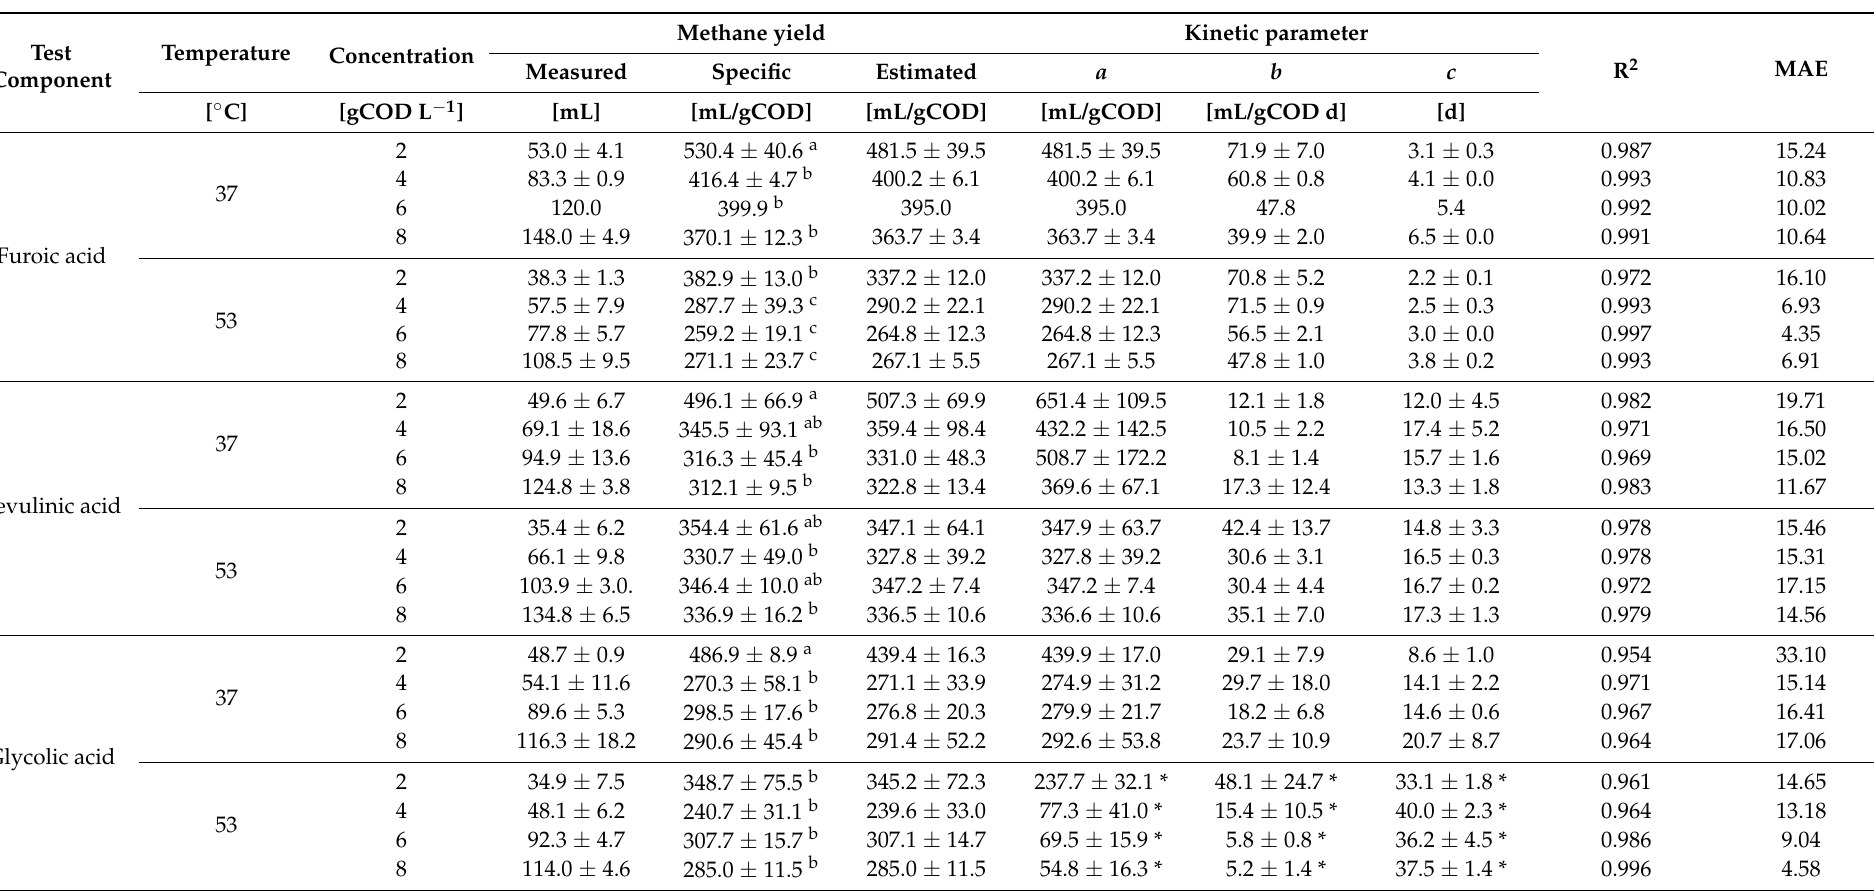
Table 6. Mean methane yields for the given concentrations of the acidic compounds under mesophilic and thermophilic conditions with kinetic parameters ( a :